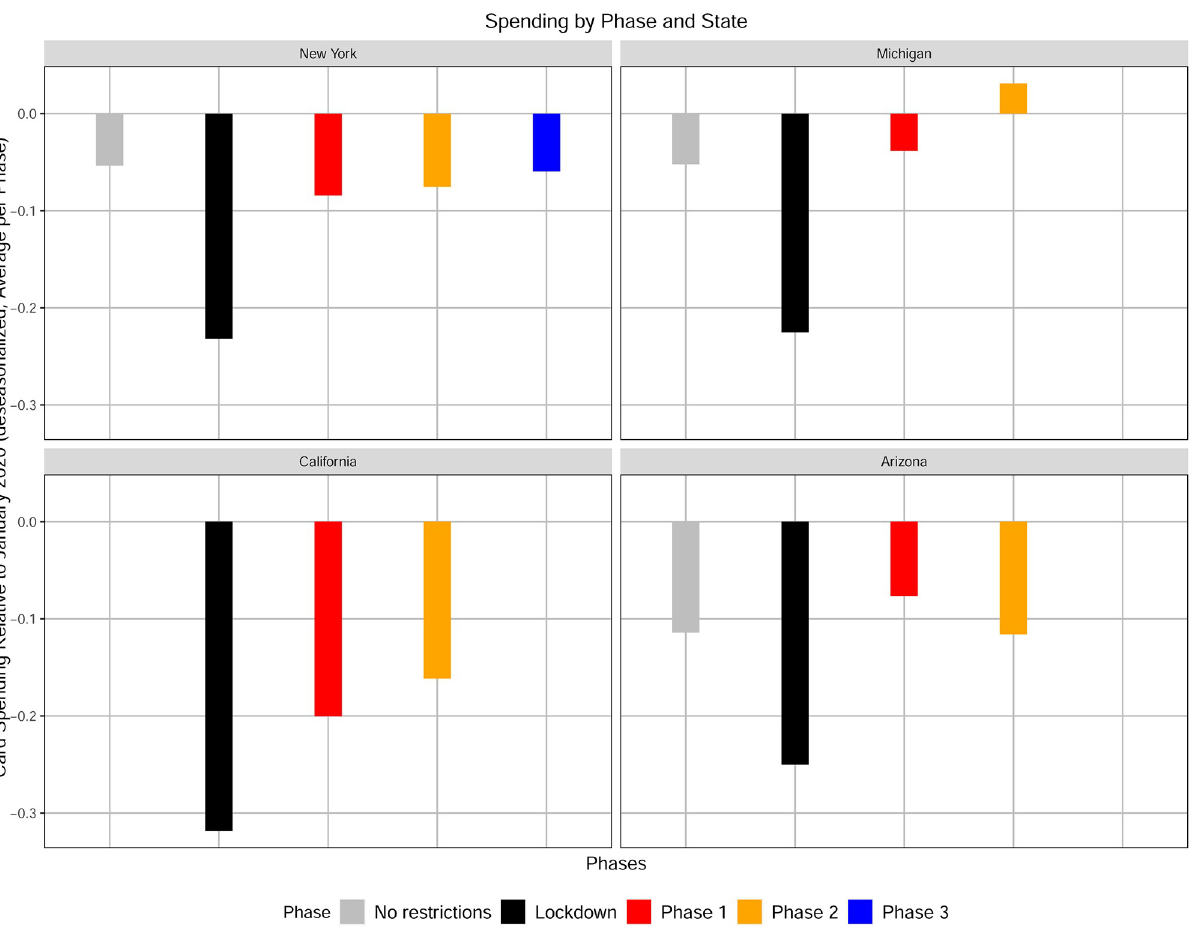
Fig 2. Average change in consumer card spending per phase in New York, Michigan, California and Arizona. Each bar represents the average change in consumer card spending (de-seasonalized and relative to January 2020) observed in the lockdown (black) and each phase of reopening defined by the White House/CDC guidelines. Each data point in the averaging represents the seven day moving average of the change in consumer card spending, de-seasonalized and relative to January 2020, in each state.